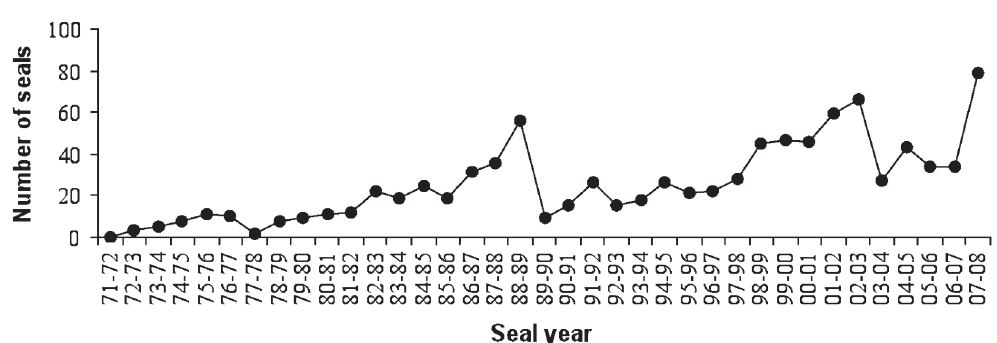
Fig. 4. Admitted orphaned common seals per seal